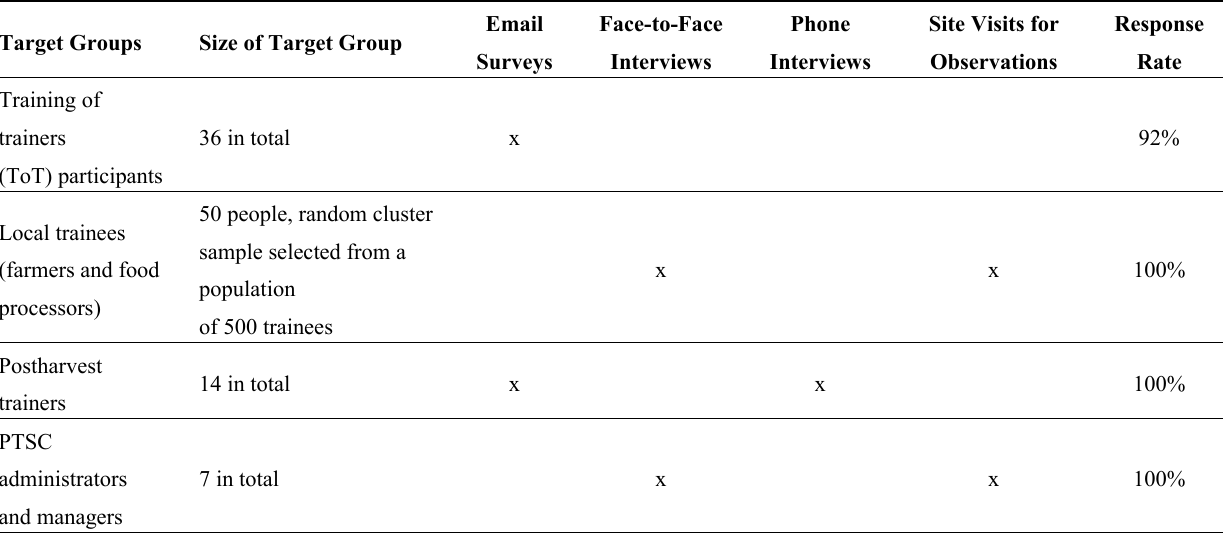
Table 1. Data collection plan and